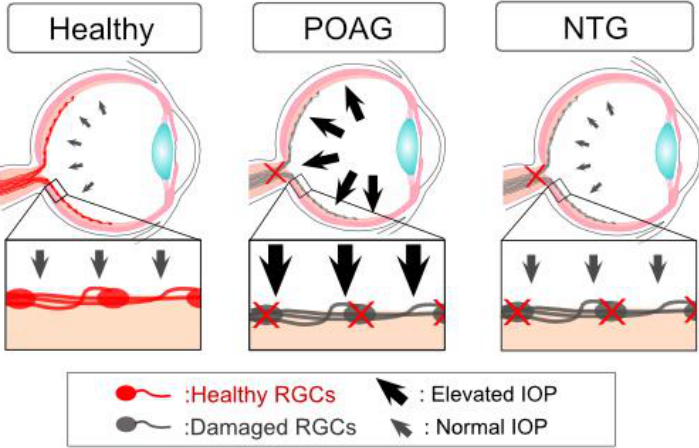
Figure 1. Elevated intraocular pressure (IOP) and glaucoma. Elevated IOP is a well-known risk factor for hypertensive glaucoma (POAG). The simplest hypothesis is that IOP-mediated physical stress may directly damage retinal gan- glion cells (RGCs) and the optic nerve. Accumulating evidence suggests that elevated IOP alone does not determine whether patients develop glaucoma but that other factors also contribute to the pathogenesis of glaucoma. In the case of NTG, glaucoma is developed even if the patients have a normal level of IOP.